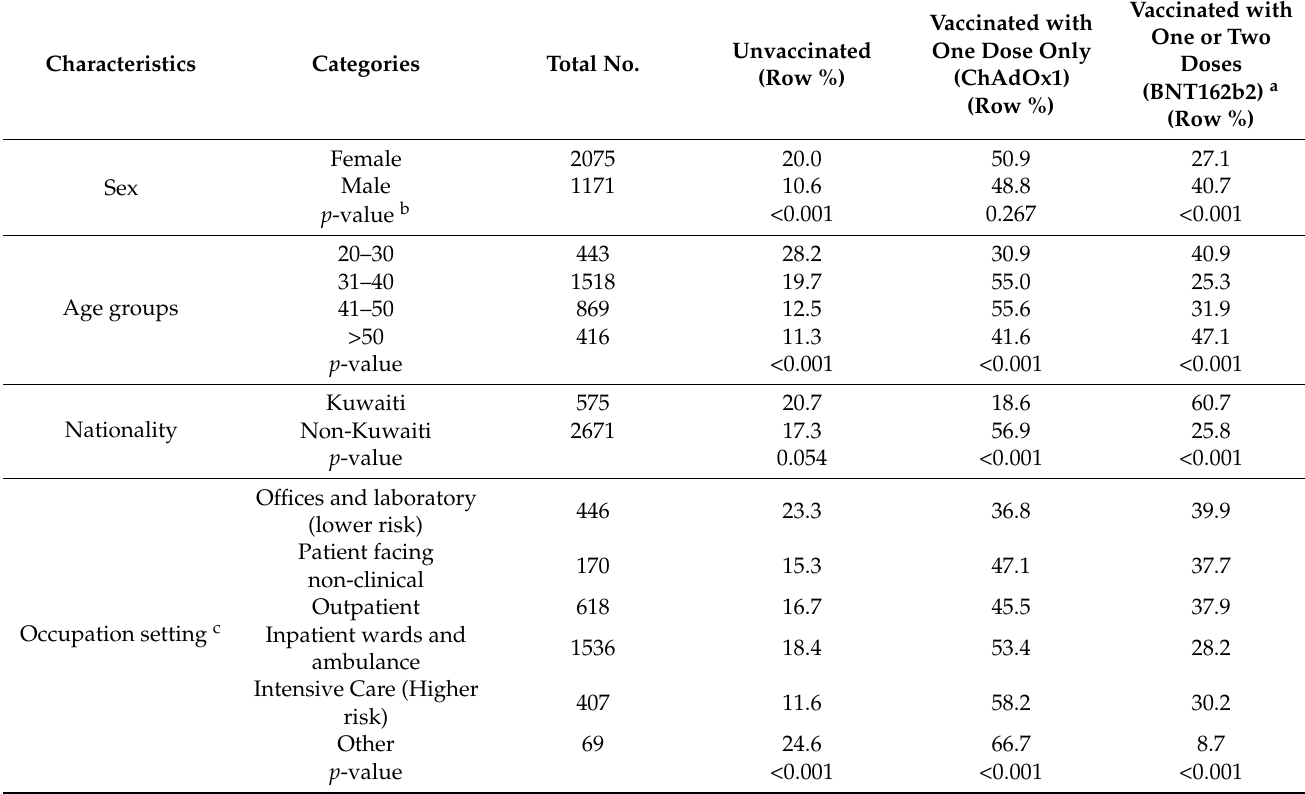
Table 1. Characteristics of vaccinated and unvaccinated HCWs ( n = 3246) and factors associated with ChAdOx1 or BNT162b2 coverage at a major secondary hospital in Kuwait, 24 December 2020–15 June 2021.